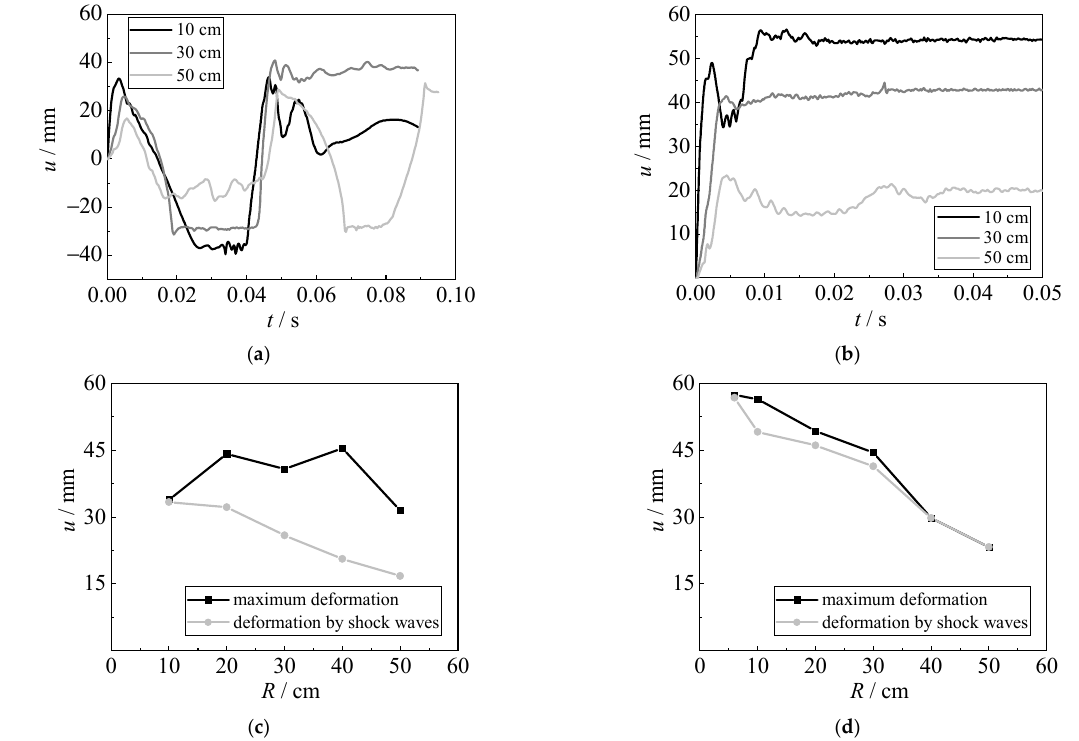
Figure 20. Effect of detonation distance. ( a ) Displacement time histories (5 g TNT). ( b ) Displacement time histories (10 g TNT). ( c ) Deformation (5 g TNT). ( d ) Deformation (10 g TNT).